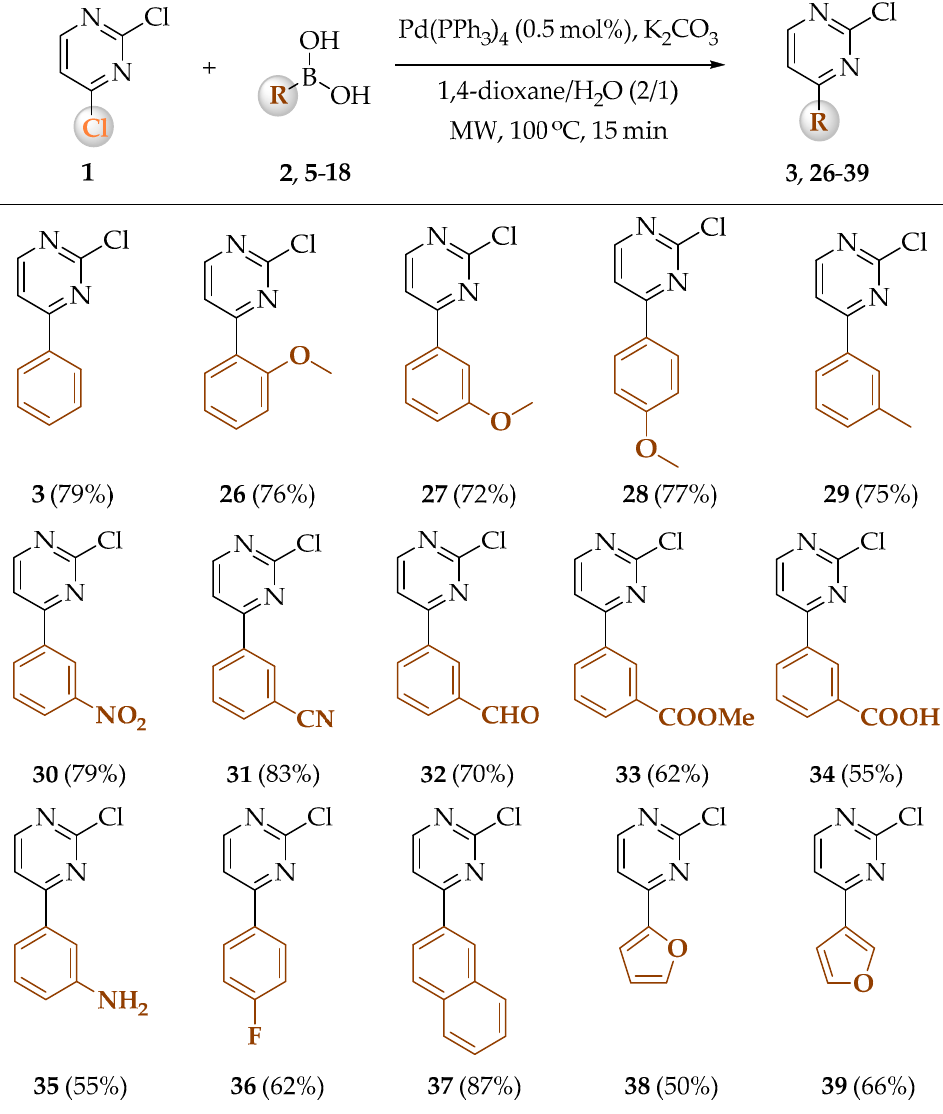
Table 6. Microwave-assisted Pd(PPh 3 ) 4 -catalyzed Suzuki coupling of aryl and heteroaryl boronic acids with 1 .